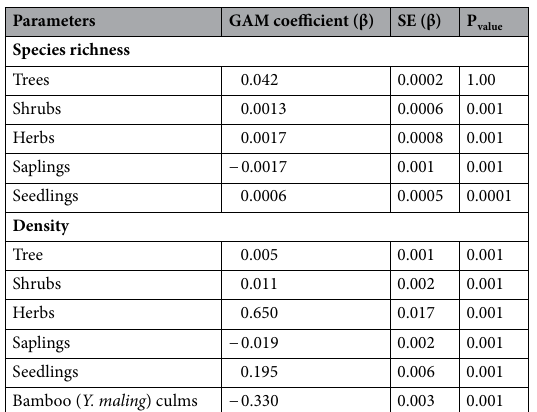
Table 1. Species richness in different vegetation layers along the elevation gradient in Singalila National Park of Khagchendzonga Landscape-India. β generalized additive model coefficient, SE standard error.